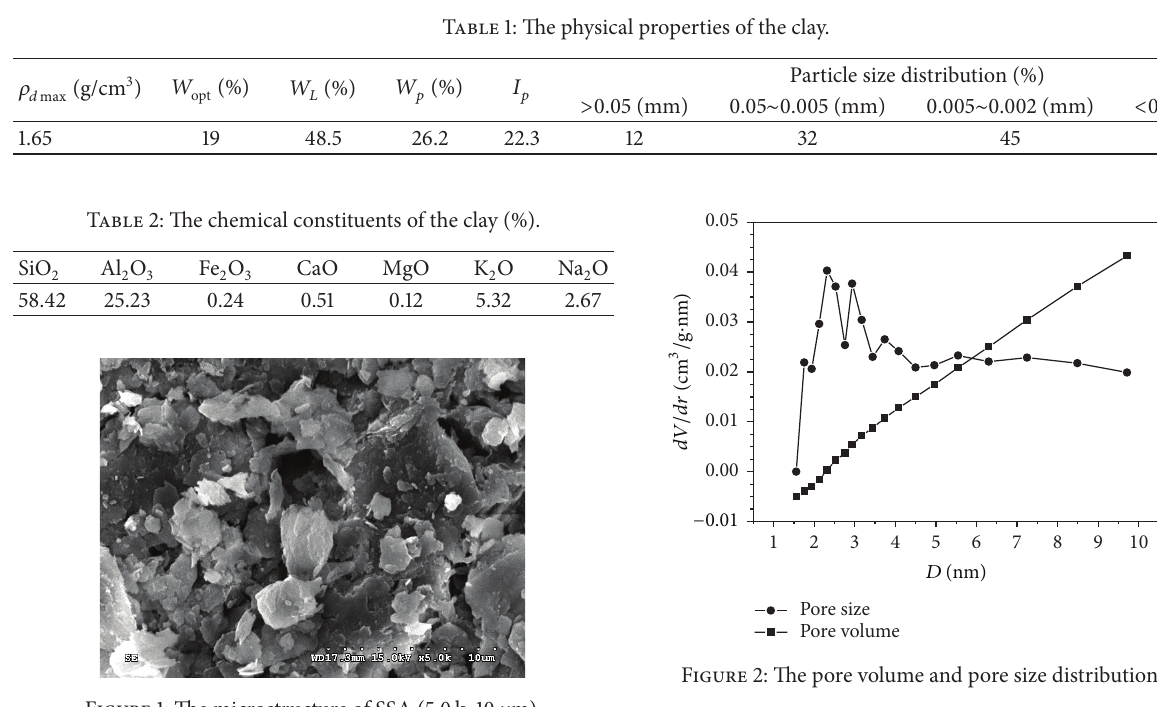
Figure 1: The microstructure of SSA (5.0 k, 10 𝜇 m).